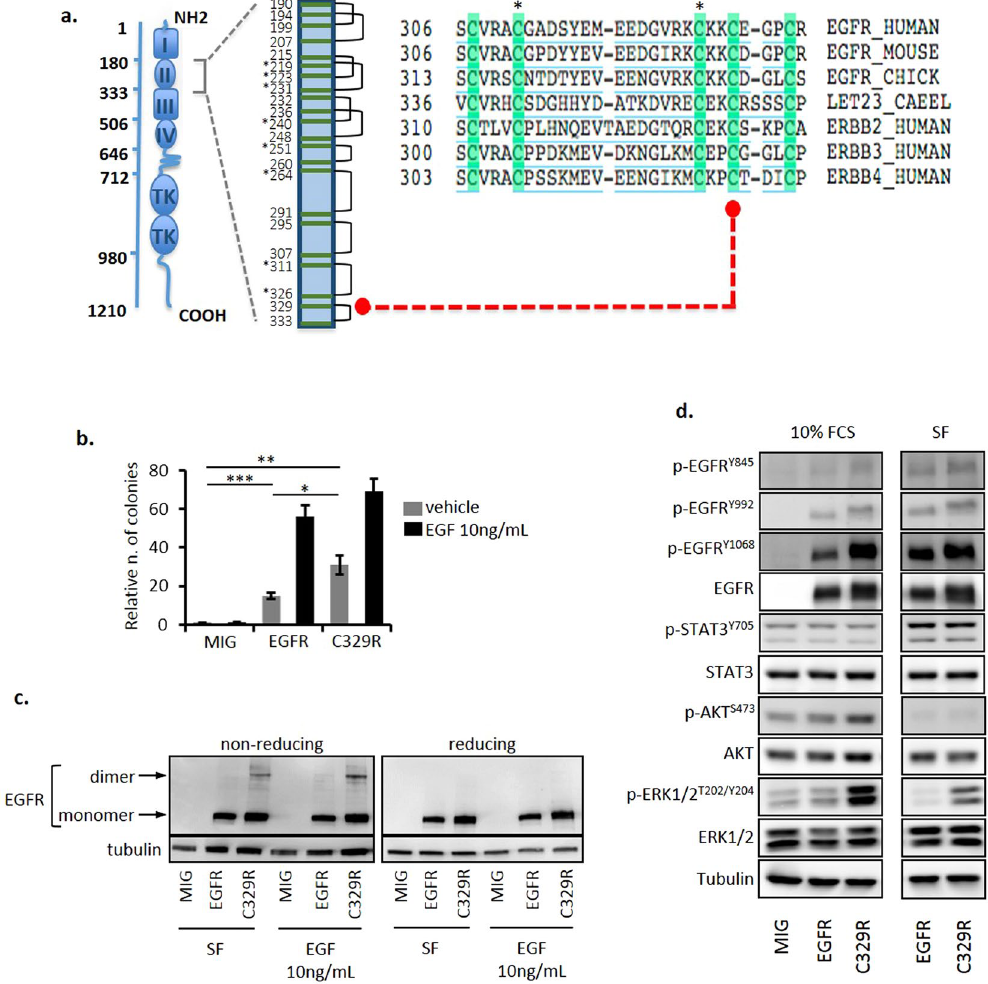
Figure 1. The EGFR C329R mutant induces colony formation, covalent receptor dimerization and altered signalling responses in NIH3T3 cells. ( a ) The affected cysteine residue 329 in EGFR (red dot) is highly conserved among species. * Indicates cysteine residues previously identified as mutated in solid tumours (COSMIC - Catalogue of Somatic Mutations in Cancer - v75 - http://cancer.sanger.ac.uk/cancergenome/ projects/cosmic/). ( b ) Anchorage-independent colony-forming potential was assessed in NIH3T3/MIG, NIH3T3/EGFR and NIH3T3/C329R with or without EGF (10 ng/mL). Bars represent mean ± SE of 3 independent experiments performed in triplicate. T-test statistical analysis * P < 0.05, ** P < 0.01, *** P < 0.001. ( c ) EGF-dependent and -independent covalent dimerization was determined in non-reducing and reducing western blot for total EGFR in lysates from NIH3T3/MIG, NIH3T3/EGFR and NIH3T3/C329R. Dimeric and monomeric species are indicated by arrows. These are cropped blots, full-length blots are presented in Suppl. Figure S3. ( d ) Western blot analysis of signalling responses in the presence or absence of serum (10% FCS and SF, respectively) in NIH3T3/MIG, NIH3T3/EGFR and NIH3T3/C329R lysates using indicated antibodies. These are cropped blots, full-length blots are presented in Suppl. Figure